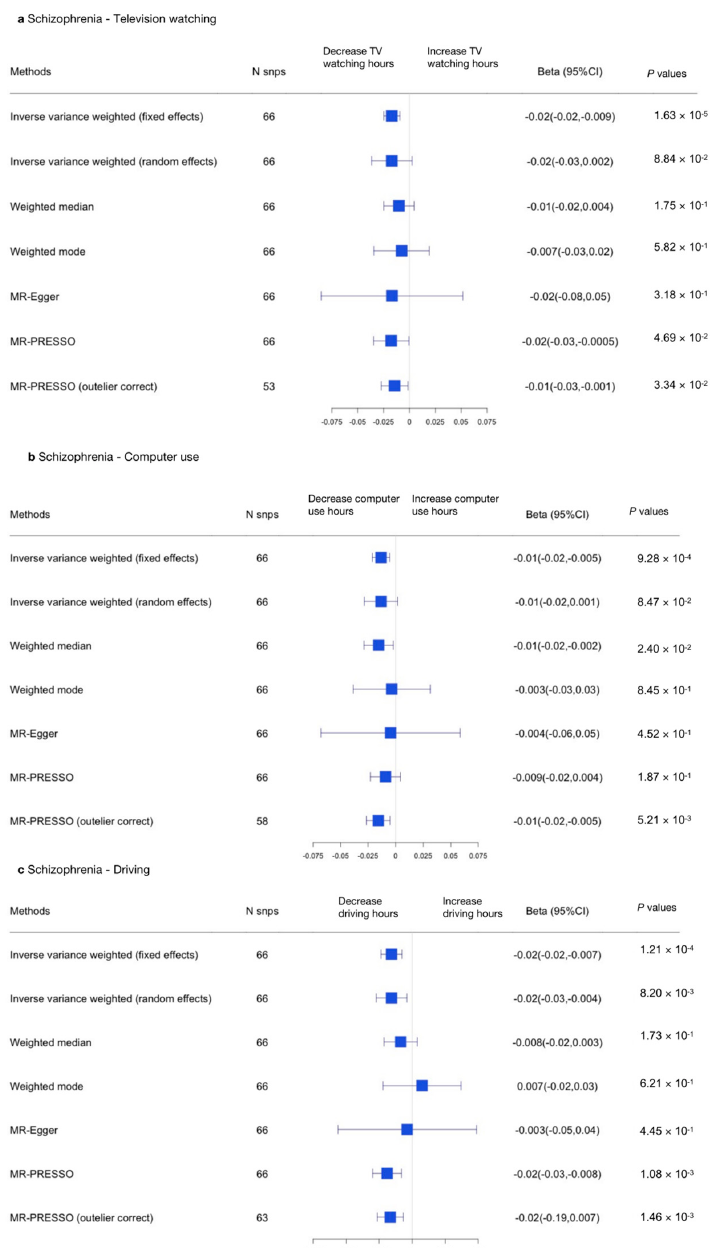
Figure 5. Summarized Mendelian randomization (MR) effect sizes of SCZ and sedentary behaviors. Summarized MR effect sizes of the causal relationship between SCZ and ( a ) television watching time, ( b ) computer use time, and ( c ) driving time were estimated using the following